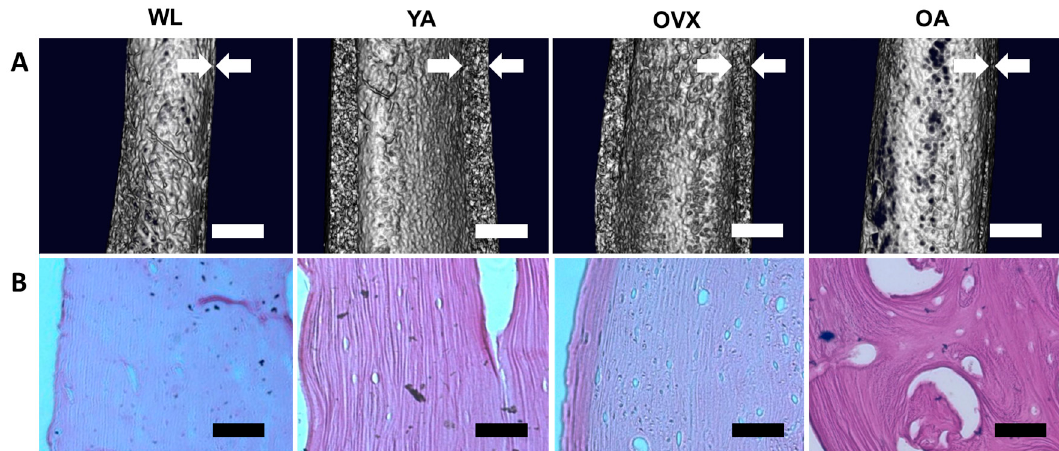
Figure 1. Macro-observation of the femoral bone shaft. ( A ) MicroCT images of the midshaft part of the femoral bones in four different models. White arrows indicate the cortical thickness. Scale bar: 1 mm. ( B ) Hematoxylin and eosin (H&E) staining images of the decellularized cortical bones. The extracellular matrix is stained in violet, suggesting that the bone matrix remains after decellularization treatment, while cells are removed. Scale bar: 100 µm.